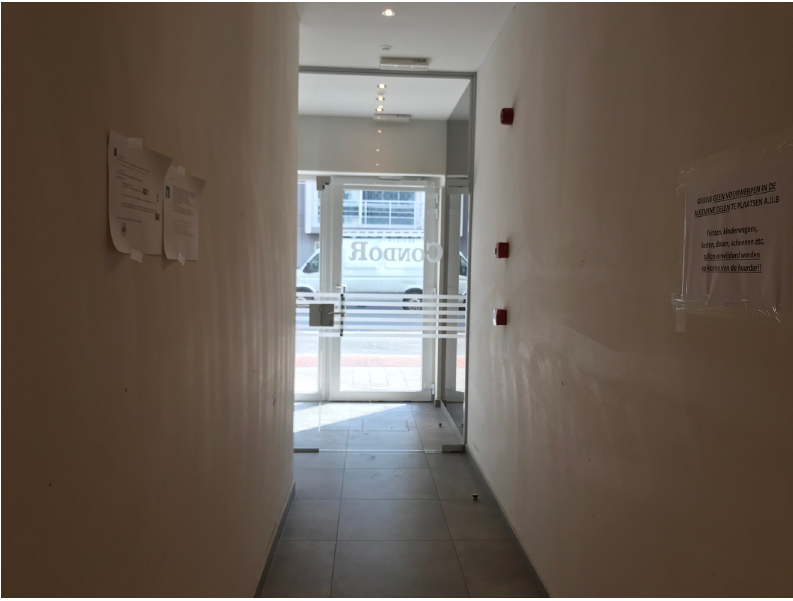
The entrance of the building, where Leo lives, is narrow and relatively